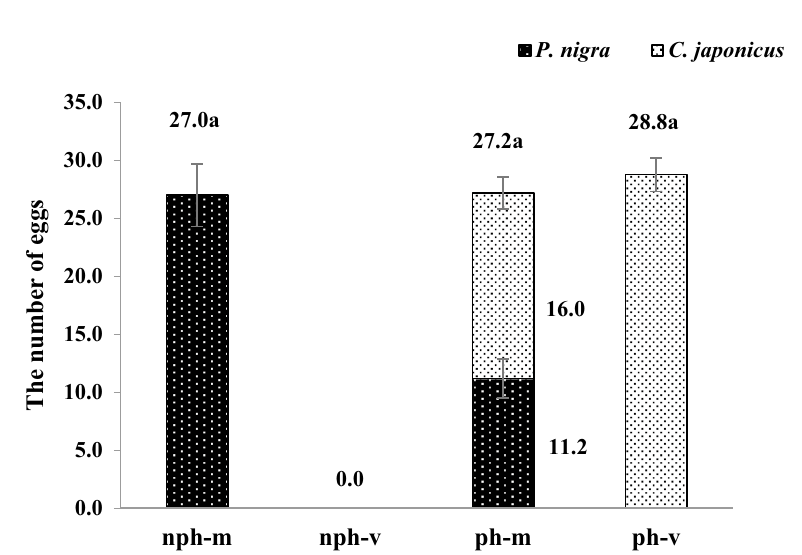
Figure 12. The number of eggs laid by virgin and mated female C. japonicus at different hosts. Data in the figure are mean ± standard error, different letters indicate significant differences in Duncan’s test, with a probability of 5%; nph-m: when the host has not been parasitized, the number of eggs laid by a mated female; nph-v: when the host has not been parasitized, the number of eggs laid by a virgin female; ph-m: when the host has been parasitized, the number of eggs laid by a mated female; ph-v: when the host has been parasitized, the number of eggs laid by a virgin female; P. nigar : the number of eggs laid in P. nigar by a female; C. japonicus : the number of eggs laid in C. japonicus by a